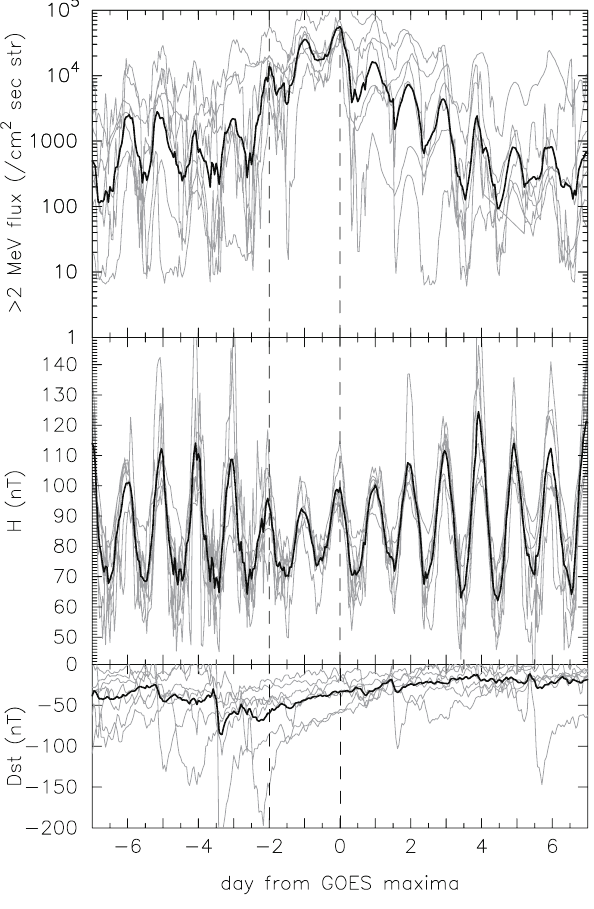
Fig. 2. Average profiles of GOES-12 > 2.0MeV electron flux and magnetic field at GEO during extreme events superposed at 17 UT of the day of maximum flux enhancement: (top) > 2.0MeV electron flux, (middle) magnetic filed H component in the VDH-coordinate system, (bottom) the D st index. In order to avoid any contamina- tions from the solar protons, the electron data are not used when the flux of the 9–15MeV proton sensor is larger than 10/cm 2 sec str. Light gray curves show the profiles of each event. Vertical dashed lines indicate the period when the dynamic pressure has very low value of < 1.0nPa as shown in Fig.